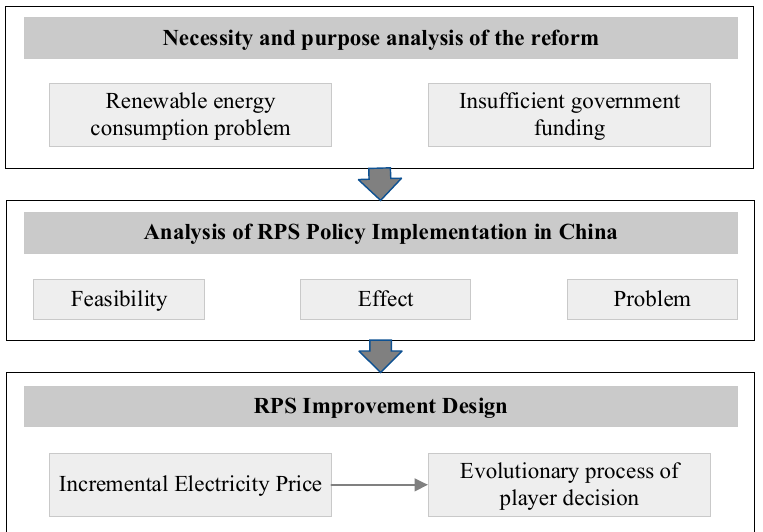
Figure 1. Flowchart of the research. RPS: renewable portfolio standard.